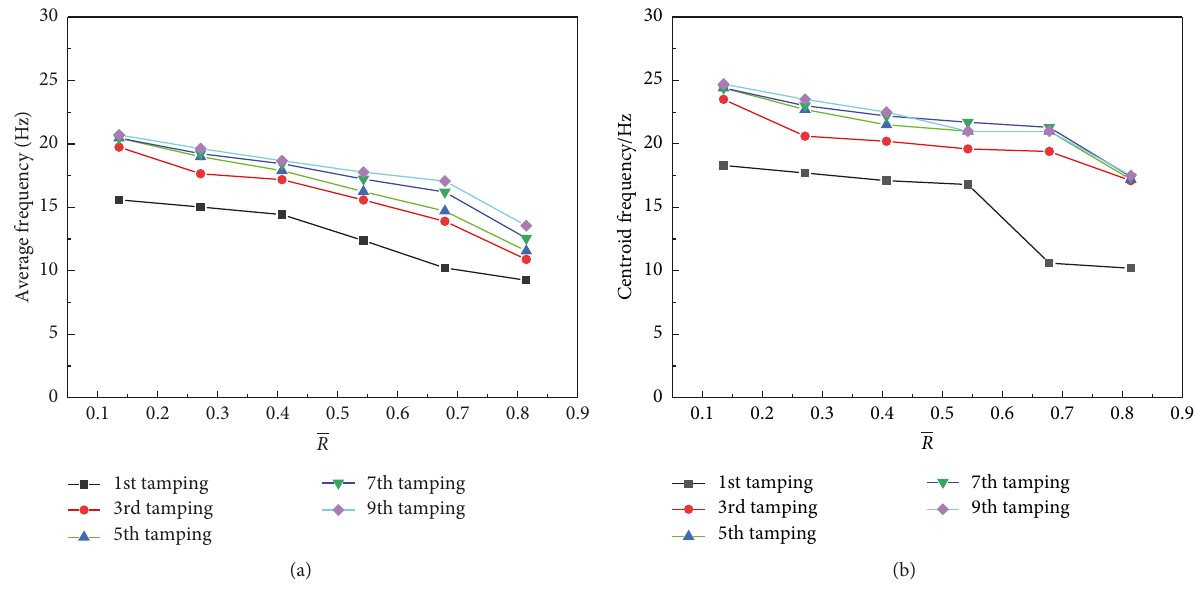
Figure 13: Attenuation of average frequency with distance under different tamping times. (a) In radial direction. (b) In vertical